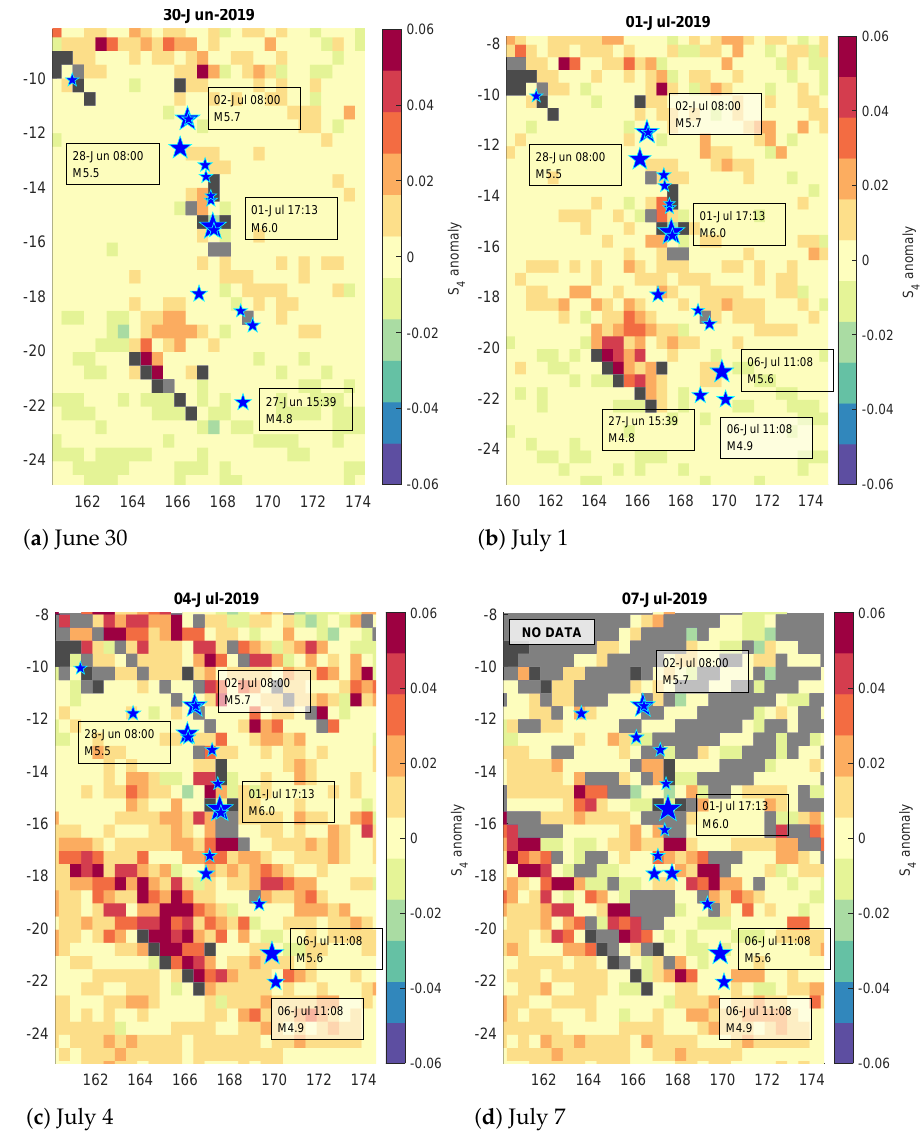
Figure 11. S 4 variations maps for selected days around Vanuatu islands at the beginning of July 2019, with a resolution of 0.5º per pixel. Stars represent the earthquakes’ epicenters with magnitudes ≥ 4.5 in the period from − 6 to +6 days from the current day. Figure 12 presents different plots for different minimum earthquake magnitudes in rows, and different integration radii, in columns. Each plot shows the averaged ∆ S 4 value of all the pixels inside a circle centered in the earthquake epicenter from 15 days before to 15 days after the event, and then averaged for all the earthquakes in the period from 1 March, to 29 August 2019. Only earthquakes that are surrounded by at least 40% water pixels are computed in this average. This filter is applied to remove false alarms due to earthquakes that occur on land, but close enough to the sea to have enough pixels with valid data. A low number of data points to average may produce unrealistic results. The total number of earthquakes in this period, and those remaining after filtering with the water coverage, are shown in each